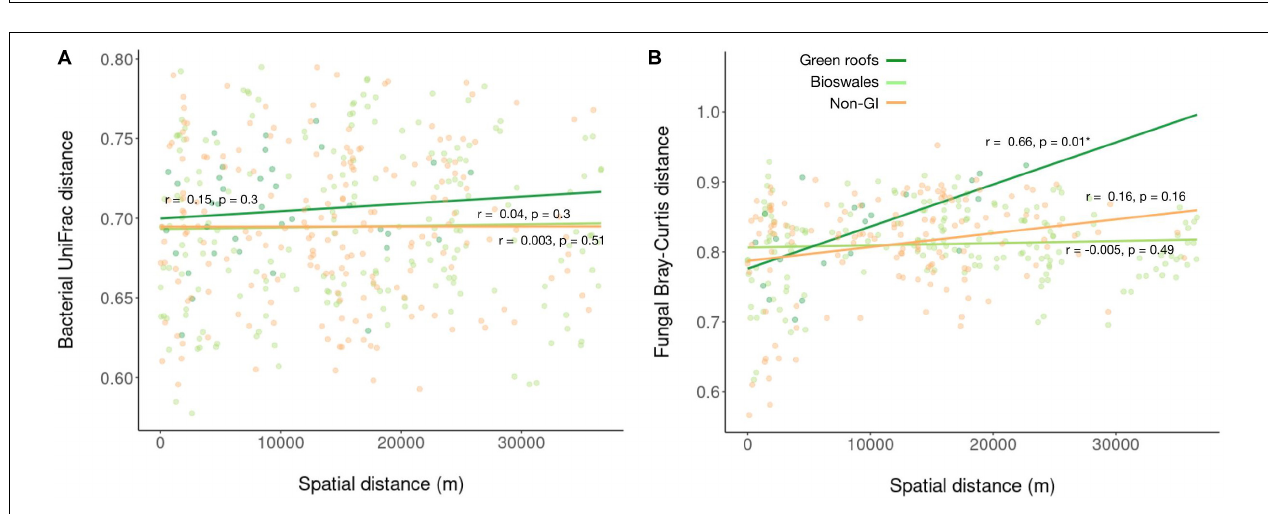
FIGURE 2 | Summary of diversity metrics for bacterial (A–C) and fungal (D–F) communities. Phylogenetic diversity (A,D) , NMDS ordination plots based on Bray–Curtis distances (B,E) , and Venn diagrams of taxonomic overlap of core microbiomes (C,F) are shown for bioswales, green roofs and non-engineered sites (tree pits and park lawns). Core microbiomes were defined as the set of ASVs present in at least half the samples in a given group, with a mean abundance of at least 10 across all sites. Differences in mean phylogenetic diversity values were evaluated with Kruskal–Wallis and Wilcoxon tests. ANOSIM tests for clustering were significant ( p < 0.001) for all groups shown. * p < 0.05, ** p < 0.01, *** p < 0.001.